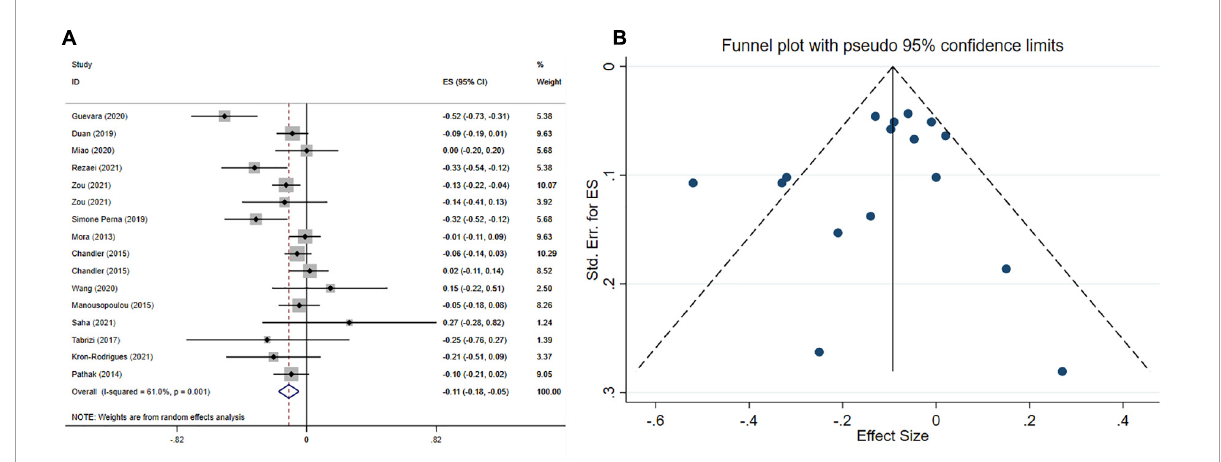
FIGURE3 Forest plot (A) funnel plot with a mean difference and 95% confidence intervals (CIs) (B) publication bias in the studies reporting, the effects of vitamin D supplementation on BMI levels.